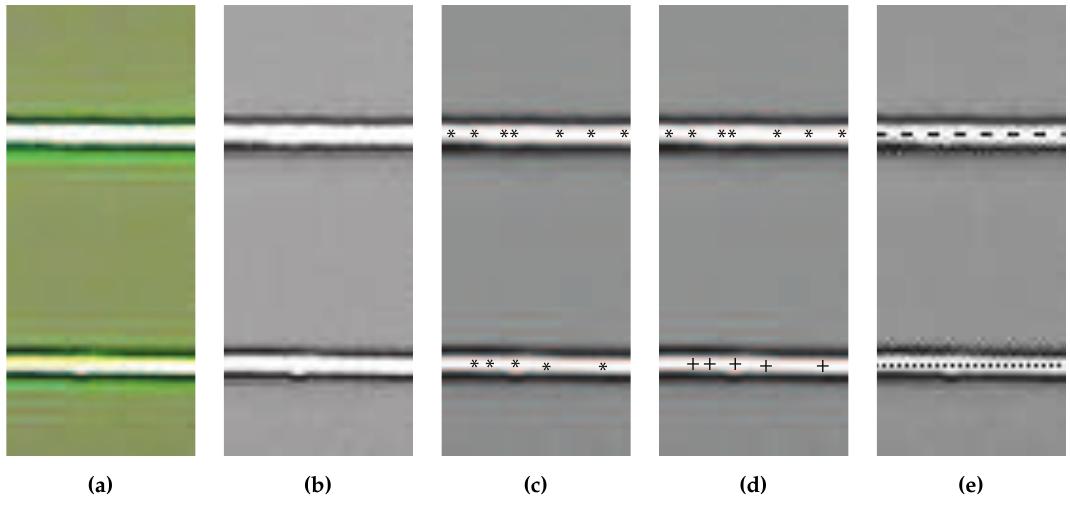
Figure 10. Each step of the laser line extraction algorithm: ( a ) original image; ( b ) green color plane extracted; ( c ) column maximums identified; ( d ) column maximums clustered; and ( e ) lines